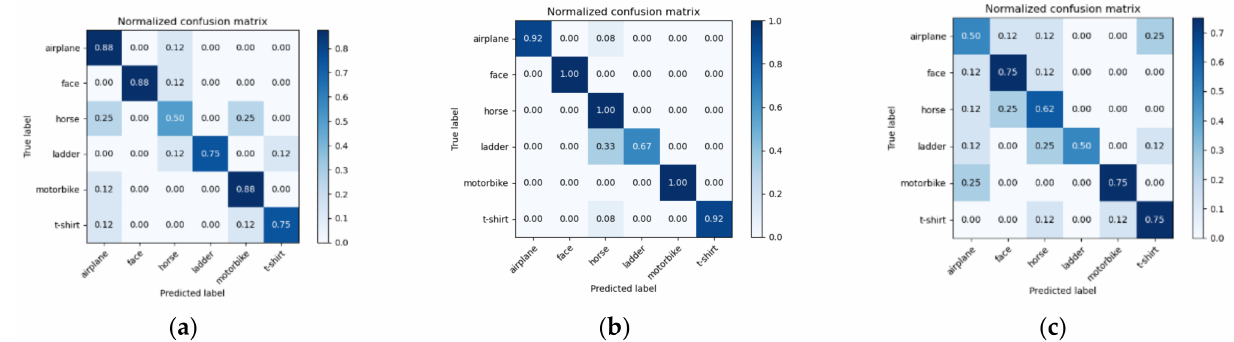
Figure 7. ( a ) Confusion matrix of SIFT_BOVW_SVM; ( b ) Confusion matrix of Hog_BOVW_SVM; ( c ) Confusion matrix of